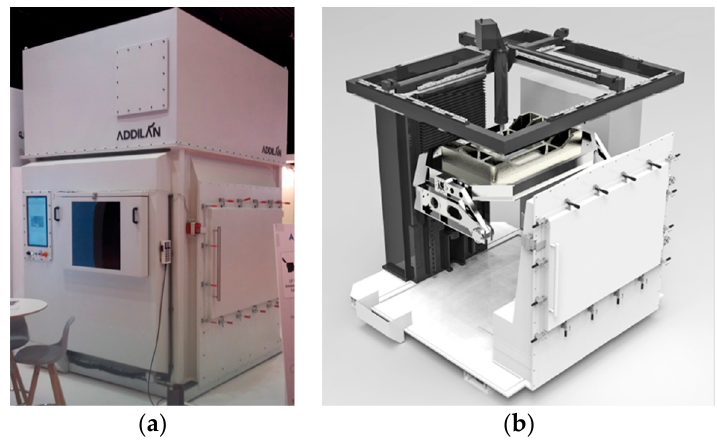
Figure 1. ( a ) General view of the machine; ( b ) Plasma equipment. Table 1. Chemical composition of the wire material employed (wt %).